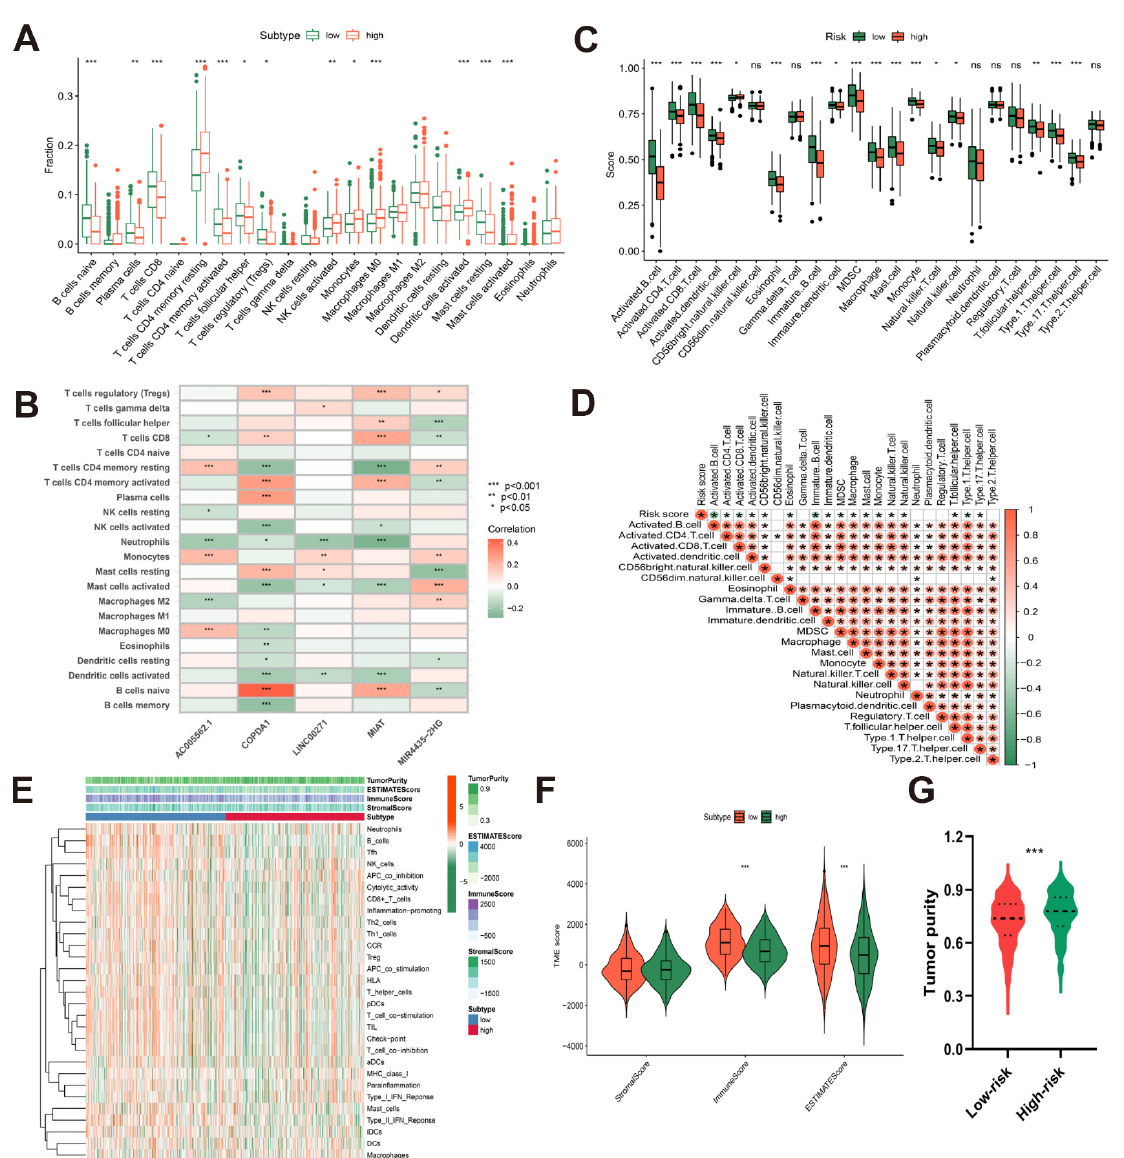
Figure 5. Correlation between risk model and immune cell infiltration patterns in TCGA-HNSCC cohort. (A) Infiltration fraction of high- and low-risk groups was assessed using CIBERSORT algo- rism; (B) the correlation analyses between the 5 m 6 A-related eRNAs of the risk model and immune cells; (C) infiltration score of high- and low-risk groups was evaluated using ssGSEA algorism; (D) the correlation analysis between risk score and immune cells; (E) heatmap showing the tumor pu- rity, ESTIMATE score, immune score, stromal score, and immune cells infiltration score of high- and low-risk groups; (F) violin plot revealing the differences in ESTIMATE score, immune score, stromal score between high- and low-risk groups; (G) violin plot revealing the differences in tumor purity between high- and low-risk groups. (* p < 0.05, ** p < 0.01, *** p < 0.01).